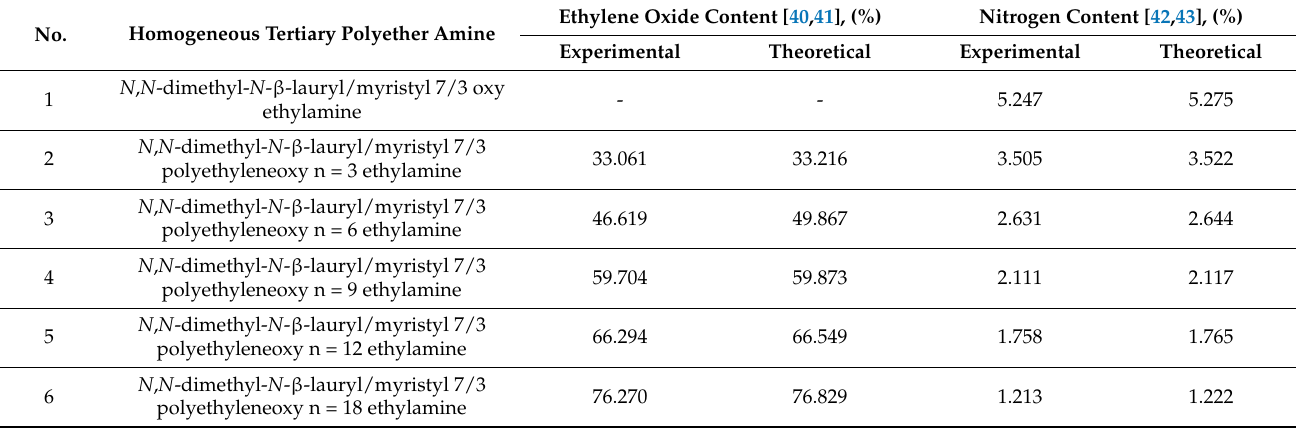
Table 11. The main chemical characteristics of homogeneous tertiary N , N -dimethyl- N - β -lauryl/myristyl 7/3 polyethyle- neoxy n = 0, 3, 6, 9, 12,18 ethylamines, LM(EO) n AT.